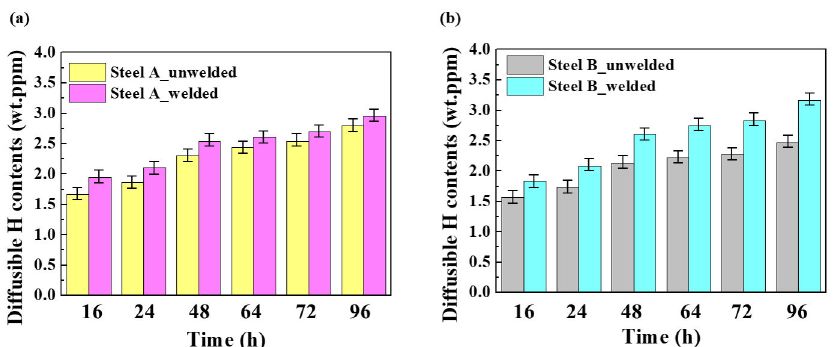
Figure 3. Diffusible hydrogen contents in the unwelded and welded samples: ( a ) Steel A and ( b ) Steel B. (Error bars represent the standard deviations of the mean